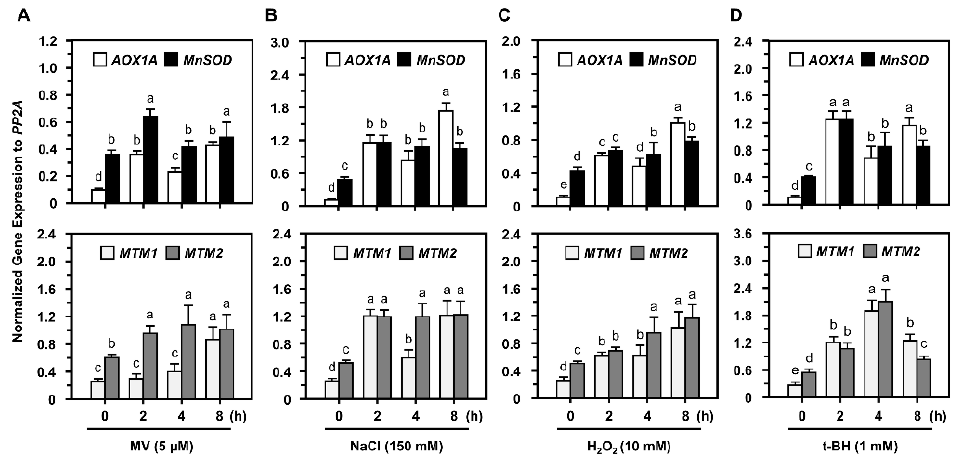
Figure 2. AtMnSOD , AtMTM1 , and AtMTM2 gene expression levels of Col in response to oxidative stressors. ( A – D ) Fourteen-day-old seedlings were incubated with 5 μM MV, 150 mM NaCl, 10 mM H 2 O 2 , or 1 mM t-BH for 2 to 8 h. Gene expressions were normalized to AOX1A which is an oxidation- responsive gene. PP2A was an input control. Data are mean ± SD of three biological replicates. The statistical significances ( p < 0.05) are indicated as different letters (Duncan’s multiple range test).